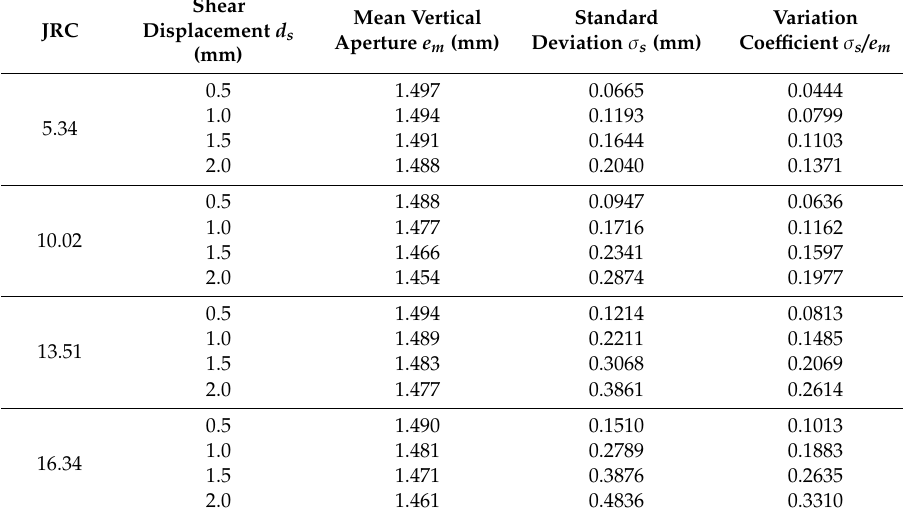
Figure 6. Gaussian distribution and vertical apertures for different shear displacements when JRC = 16.34. Table 1. Statistical parameters for Gaussian fitting of vertical aperture with di ff erent